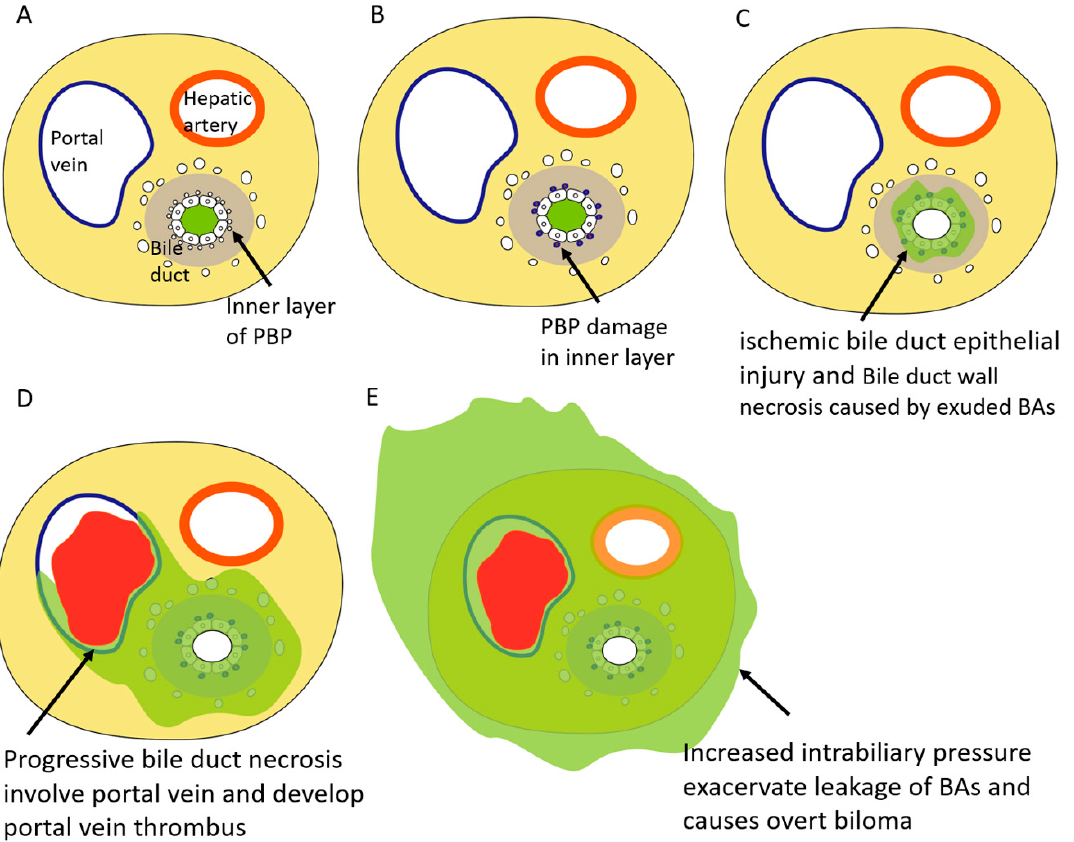
Figure 7. Schematic diagram of the development of BDN and subsequent biloma formation. In liver cirrhosis, both inner and outer vessels of PBP show dilatation and increased in number ( A ). After repeated TACE, the inner layer of PBP vessels are damaged and decreased in number ( B ). Once ischemic bile duct epithelial injury is caused by PBP disorder, toxic bile acids (BAs) exude to the bile duct wall and show necrotic change in and around bile duct, which is the early stage of BDN ( C ). If the progressive necrosis of peri-bile duct tissue caused by exuded BAs involves the portal venous branch, portal vein thrombosis can be easily developed ( D ). If ischemic bile duct injury downstream of the BDN site occurs, stenosis of the downstream bile duct may induce intrahepatic bile stasis, which causes an increase in intrabiliary pressure at the bile duct epithelial injury site, which leads to increased leakage of BAs into the surrounding tissues and causes overt biloma formation ( E ).